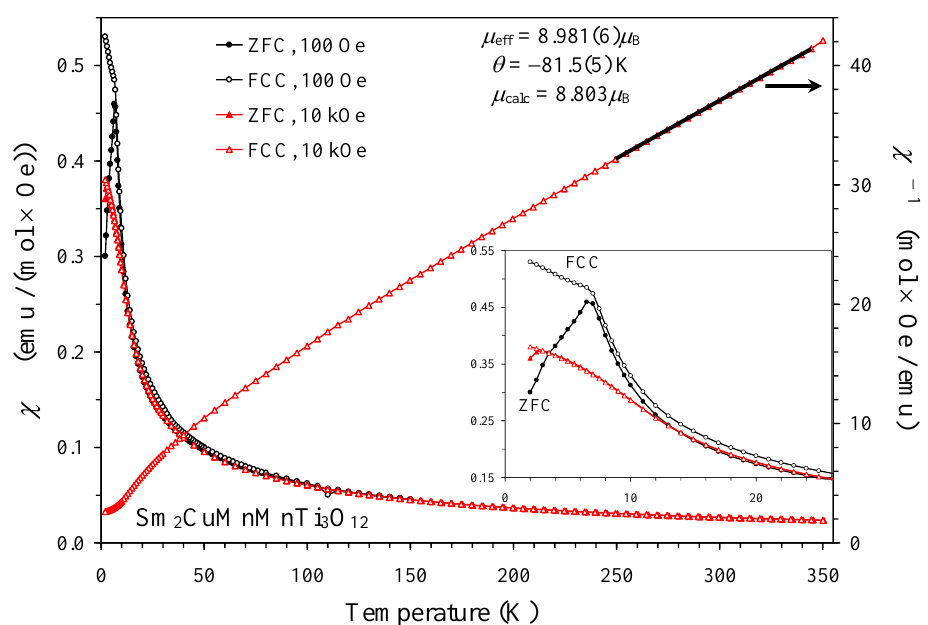
Figure 4. The left-hand axis shows the ZFC (filled symbols) and FCC (empty symbols) dc magnetic susceptibility curves ( χ = M / H ) of Sm 2 CuMn(MnTi 3 )O 12 at 100 Oe (black) and 10 kOe (red). The right-hand axis gives the 10 kOe FCC χ − 1 versus T curve with the Curie–Weiss fit between 250 K and 345 K (black line). Parameters of the fits are shown on the figure. The inset shows details below 30 K.